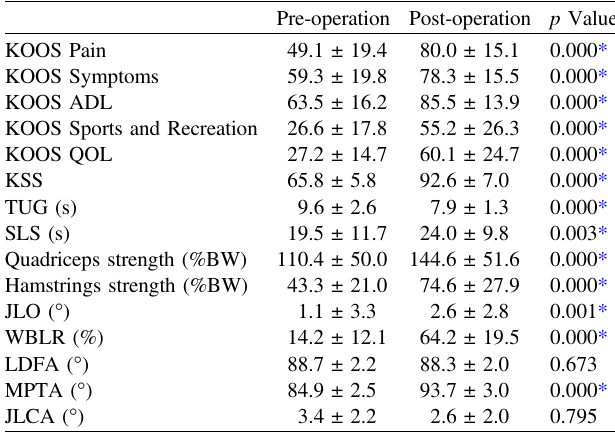
Table 1. The preoperative and postoperative clinical and radiological results.